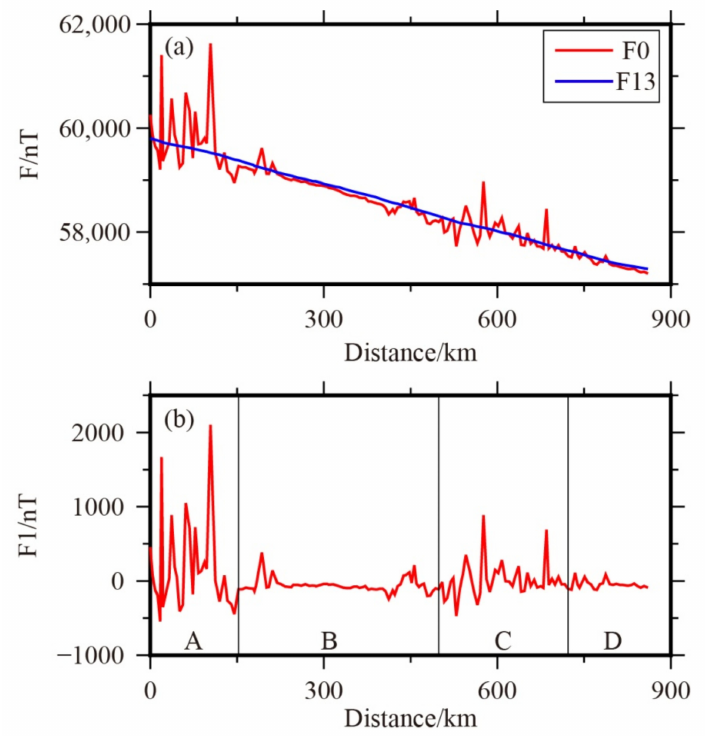
Figure 2. ( a ) The distribution of total geomagnetic intensity (F 0 ), IGRF-13 model (F 13 ). ( b ) Litho- spheric magnetic field, region A is the Vitrim orogenic belt, region B is the Erhotsk orogenic belt, region C is the Erguna orogenic belt, and region D is the Southern Mongolia orogenic belt. The meanings of A, B, C, and D are the same in all other